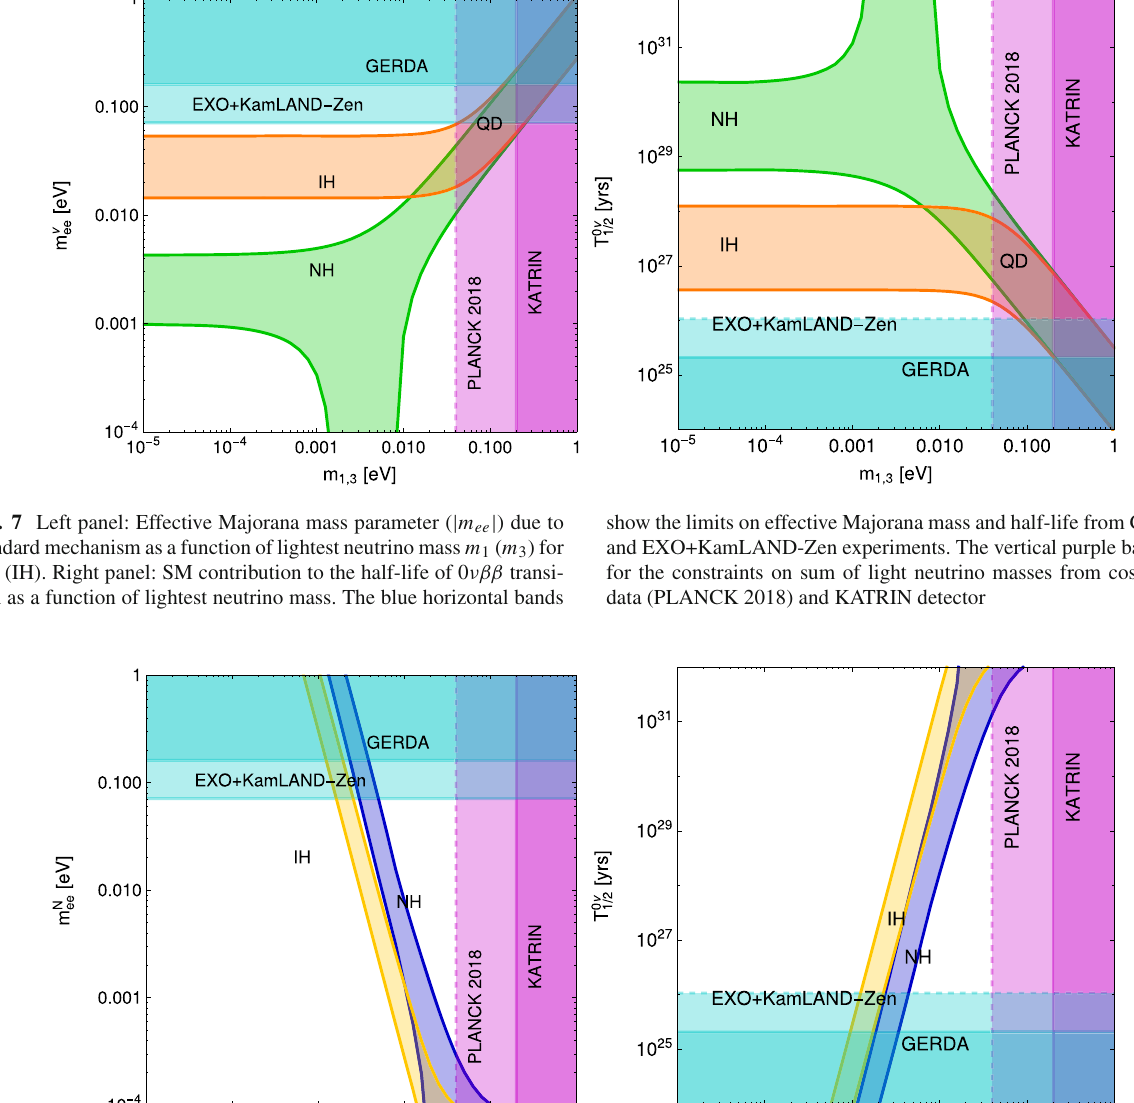
Fig. 8 Left panel: New physics contribution to effective Majorana mass as a function of lightest neutrino mass, m 1 ( m 3 ) for NH (IH) via W L − W L channel with the exchange of heavy neutrino N R and sterile neutrino S L . Right panel: Contributions of N R and S L to the plot of half-life vs lightest neutrino